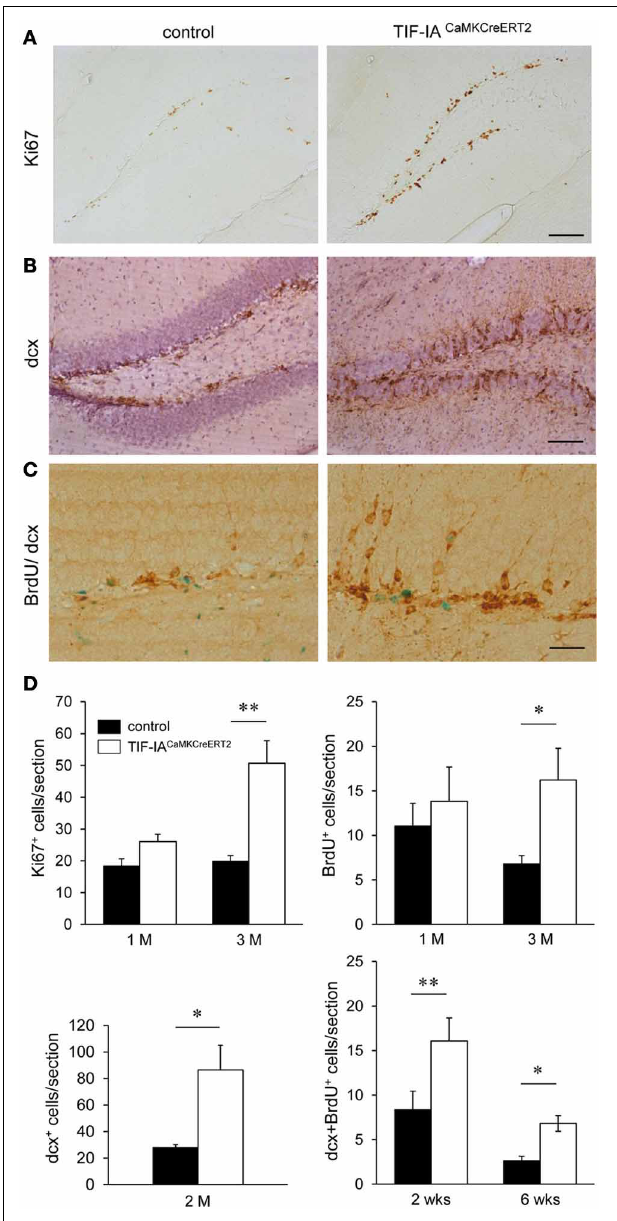
FIGURE 10 | Increased neurogenesis in TIF-IA CaMKCreERT2 mutant mice. (A) Analysis of Ki67 positive cells in the DG 3 months after tamoxifen in controls and TIF-IA CaMKCreERT2 mutants. (B) Representative images of doublecortin positive cells in the DG 3 months after tamoxifen. Hematoxylin counterstaining has been used to visualize the nuclei. (C) Control and mutant mice were injected for 5 days with BrdU 2.5 months after tamoxifen. Doublecortin (dcx) positive (brown) BrdU retaining (green) cells were counted 2 and 6 weeks after BrdU injections. (D) Quantification of Ki67 positive, and BrdU positive cells (2h after single BrdU injection) 1 and 3 months after tamoxifen (upper panels). Quantification of the increased dcx positive cells shows significant increase 2 months after tamoxifen. Quantification of doublecortin positive cells retaining BrdU staining 2 and 6 weeks after BrdU injections shows significant increase in the TIF-IA CaMKCreERT2 mutant mice (lower panels); n = 5–6. Scale bars: (A,B) 120 μ m; (C) 60 μ m. ∗ p < 0 . 05; ∗∗ p < 0 .